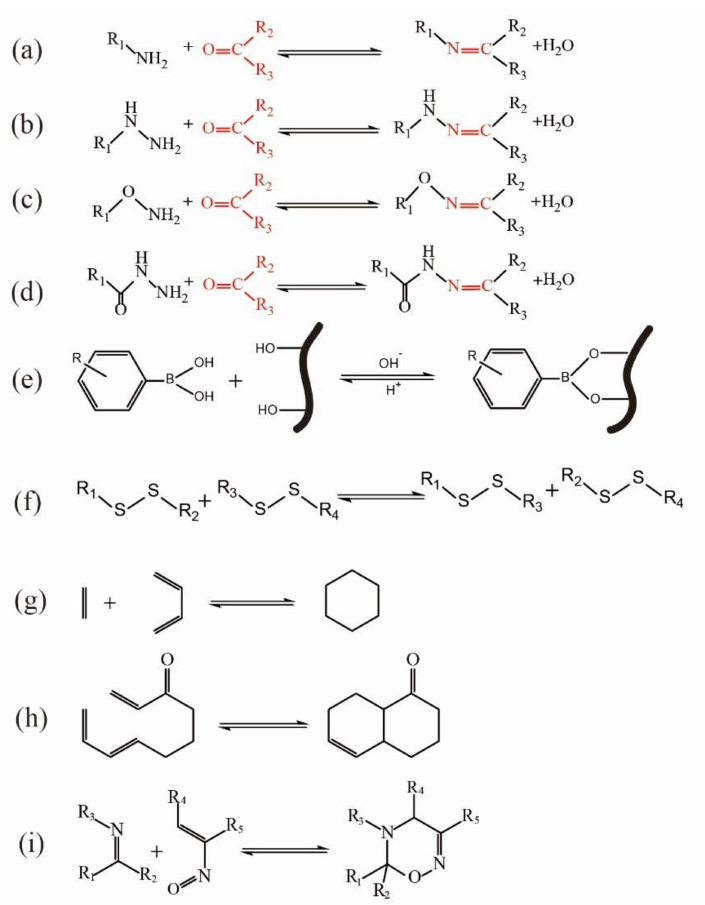
Figure 1. Self-healing hydrogels based on dynamic covalent bonds: ( a ) The imine formed between aldehyde and imine; ( b ) The hydrazone formed between aldehyde and hydrazide; ( c ) The oxime formed between aldehyde and aminooxy; ( d ) The acylhydrazone formed between aldehyde and acylhydrazide (The red color represents the substance with active carbonyl functional groups); imine or methylimine characteristic groups (-RC=N-). ( e ) The complexation equilibrium of borate ester bond; ( f ) The disulfide bonds addition reaction; ( g ) The normal electron-demand DA reaction; ( h ) The intramolecular DA reaction; ( i ) The hetero-DA